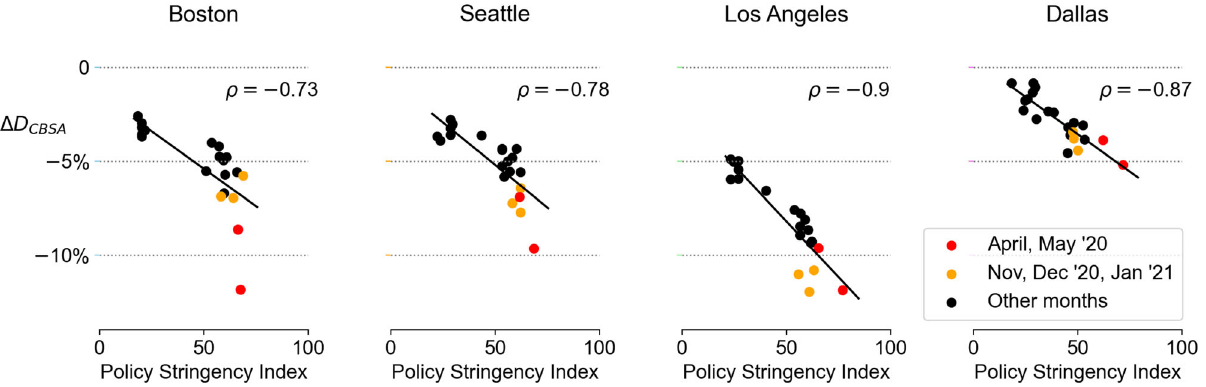
Fig. 4 | Trade-off between decreased income diversity of encounters and stringency of COVID-19 policies. Decrease in income diversity of encounters Δ D CBSA has a strong and signi fi cant correlation ρ with the stringency of COVID-19 measures (which is a composite measure of nine response metrics, including